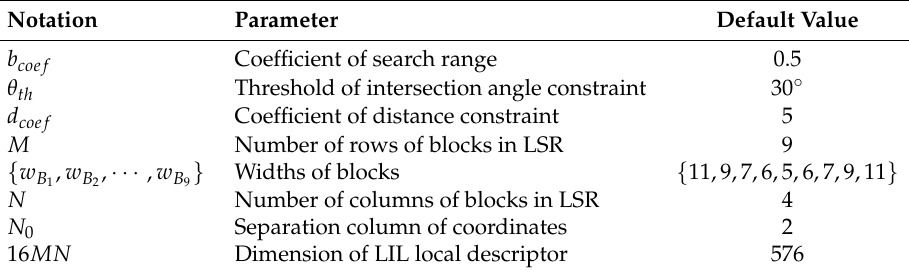
Table 1. Parameter setting.